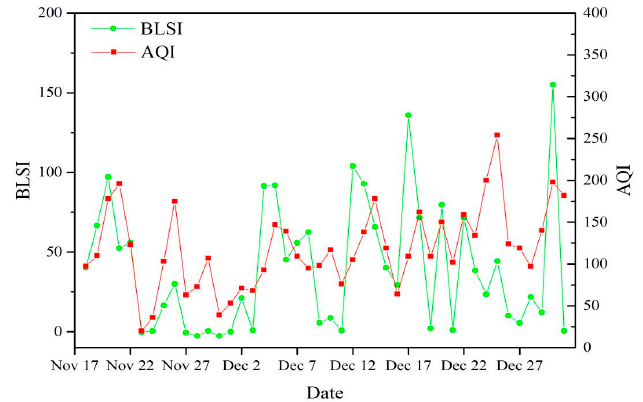
Figure 10. Changes of sequence of BLSI at 300 m (green line, multiply by 10 6 ) and AQI (red line) with time during a relatively clean period (18 November 2014–31 December 2014).